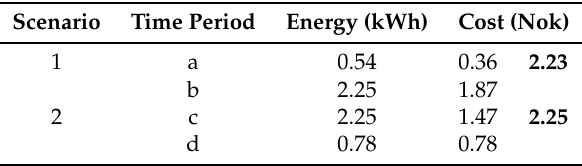
Table 5. Energy cost estimations for two different